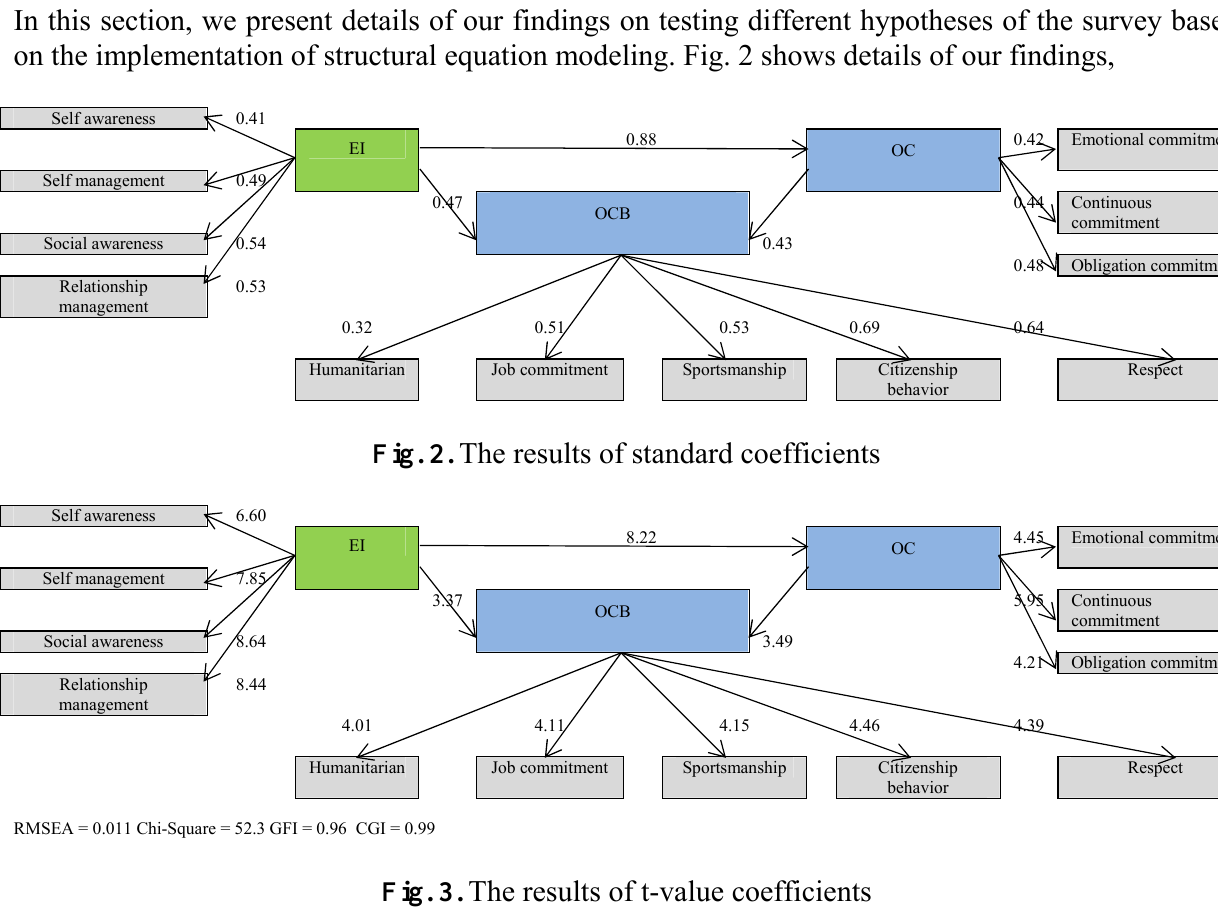
Fig. 3. The results of t-value